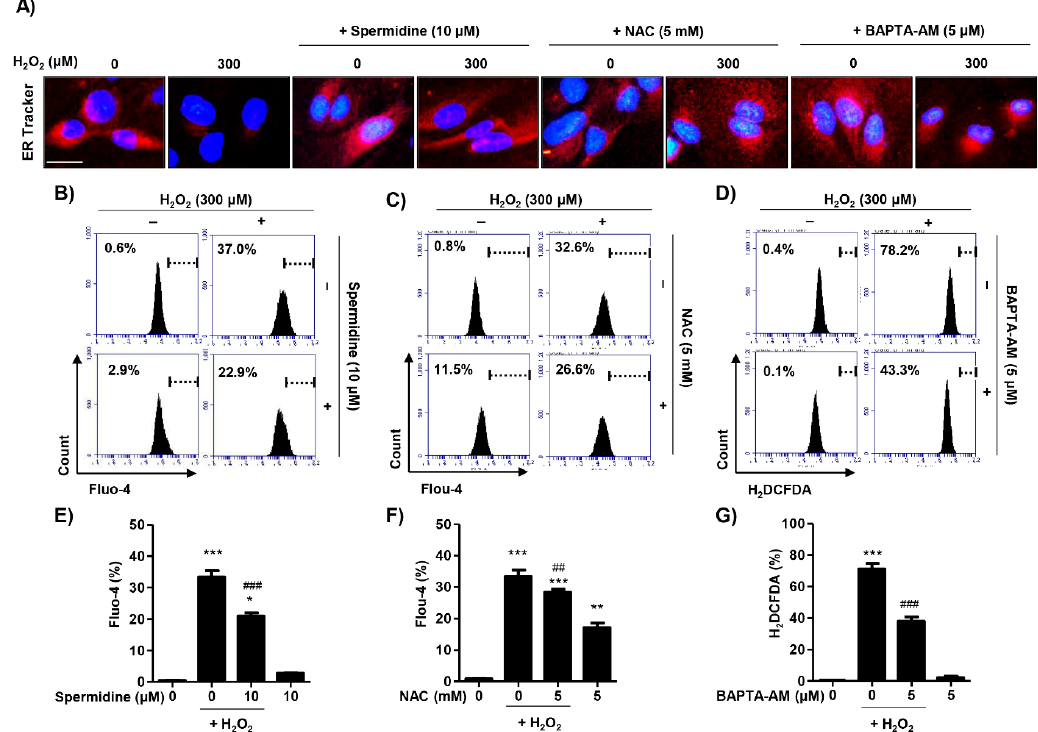
Figure 5. Effect of spermidine on cytosolic Ca 2+ concentration in H 2 O 2 -stimulated ARPE-19 cells. Cells were pre-treated with or without 10 µ M spermidine, 5 mM NAC, or 5 µ M BAPTA-AM for 1 h and then additionally incubated with 300 µ M H 2 O 2 for 24 h. ( A ) Cells stained with 1 µ M ER-Tracker Red dye and observed under a fluorescence microscope. DAPI was used to counterstained the nuclei (blue). Scale bar: 20 µ m. ( B , C , E , F ) Cells were probed with 1 µ M fluo-4 AM, an intracellular Ca 2+ indicator, for 30 min, and then fluorescence intensity was monitored using a flow cytometer. ( B , C ) Representative histograms. ( E , F ) Quantified fluo-4 AM fluorescence intensities. Data are expressed as the mean ± SD ( n = 3). * p < 0.05, ** p < 0.01, and *** p < 0.001 when compared to control. ## p < 0.01 and ### p < 0.001 when compared to H 2 O 2 -treated cells. ( D , G ) Cells were stained with 10 µ M DCF-DA and intracellular ROS generation was analyzed using a flow cytometer. ( D ) Representative histograms. ( G ) Quantification of DCF-DA fluorescence intensity. Data are expressed as the mean ± SD ( n = 3). *** p < 0.001 when compared to control. ### p < 0.001 when compared to H 2 O 2 -treated